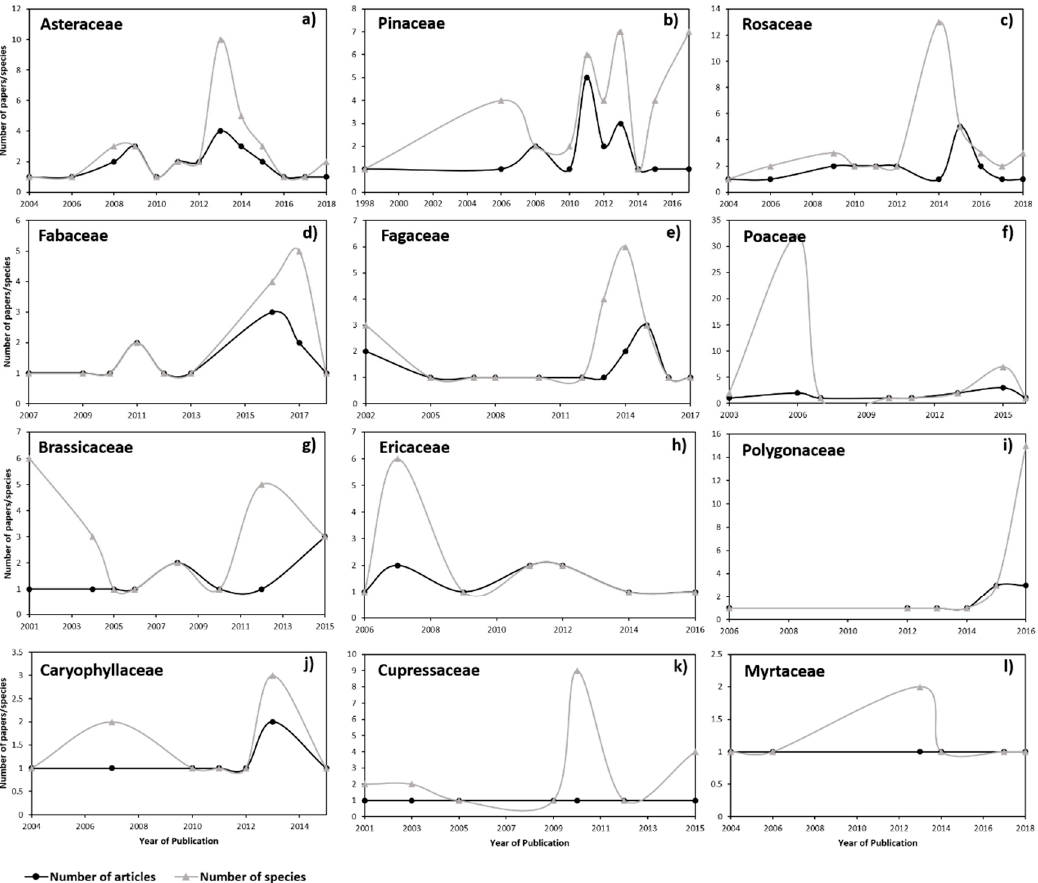
Figure 4. Yearly variation in the number of species of the most diverse plant families and the number of papers (studies of genetic diversity based on chloroplast markers) in which they were analyzed, over the past 21 years.